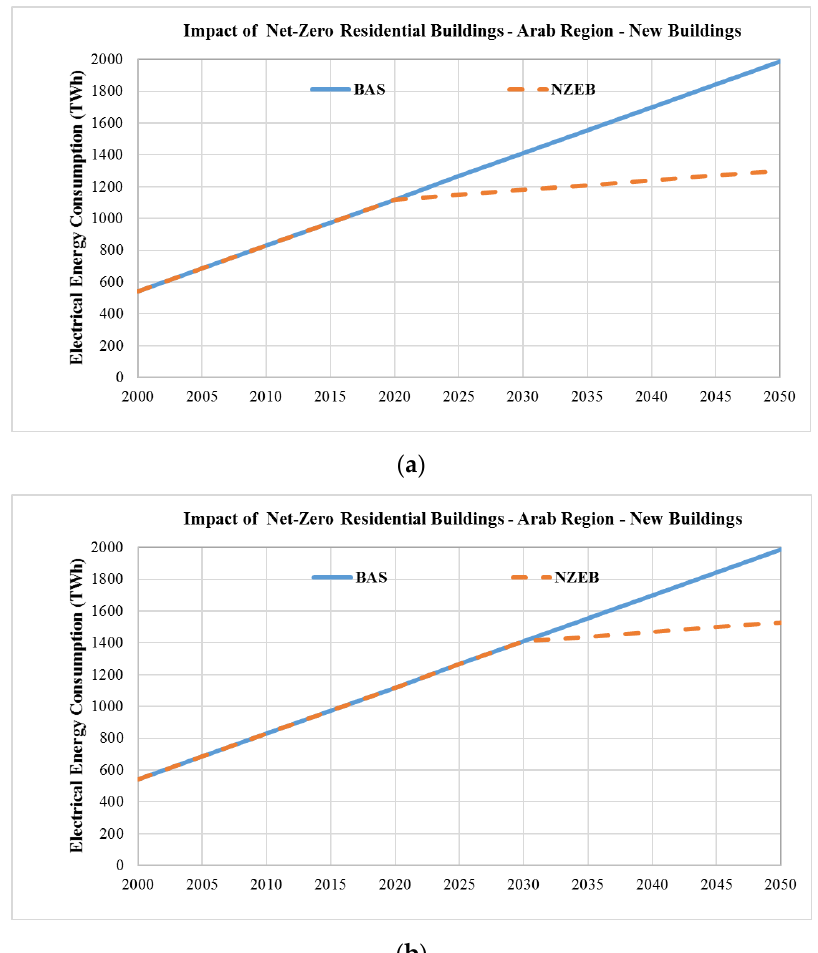
Figure 23. Impact on load profiles for electrical energy consumption due to implementation starting in ( a ) 2020, and ( b ) 2030 of net-zero residential buildings for the new housing stock in the Arab region.